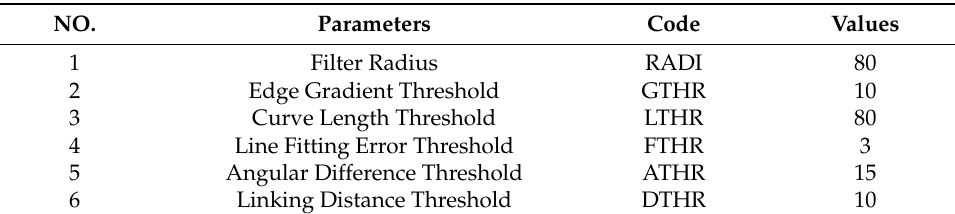
Table 1. Adopted parameters for the LINE algorithm.